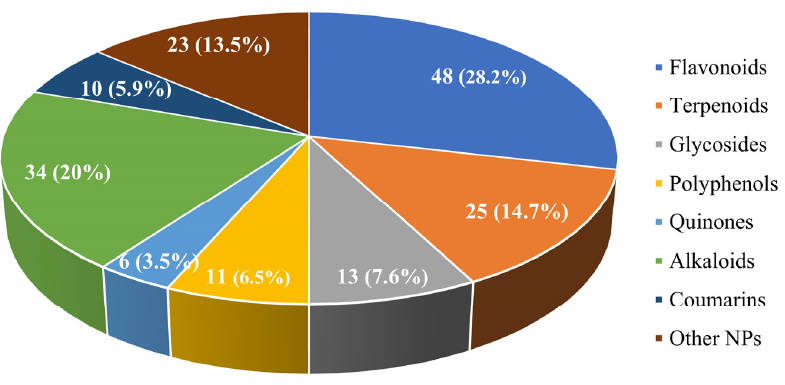
Figure 3. Number and percentage of different NPs with IBD therapeutic activity.